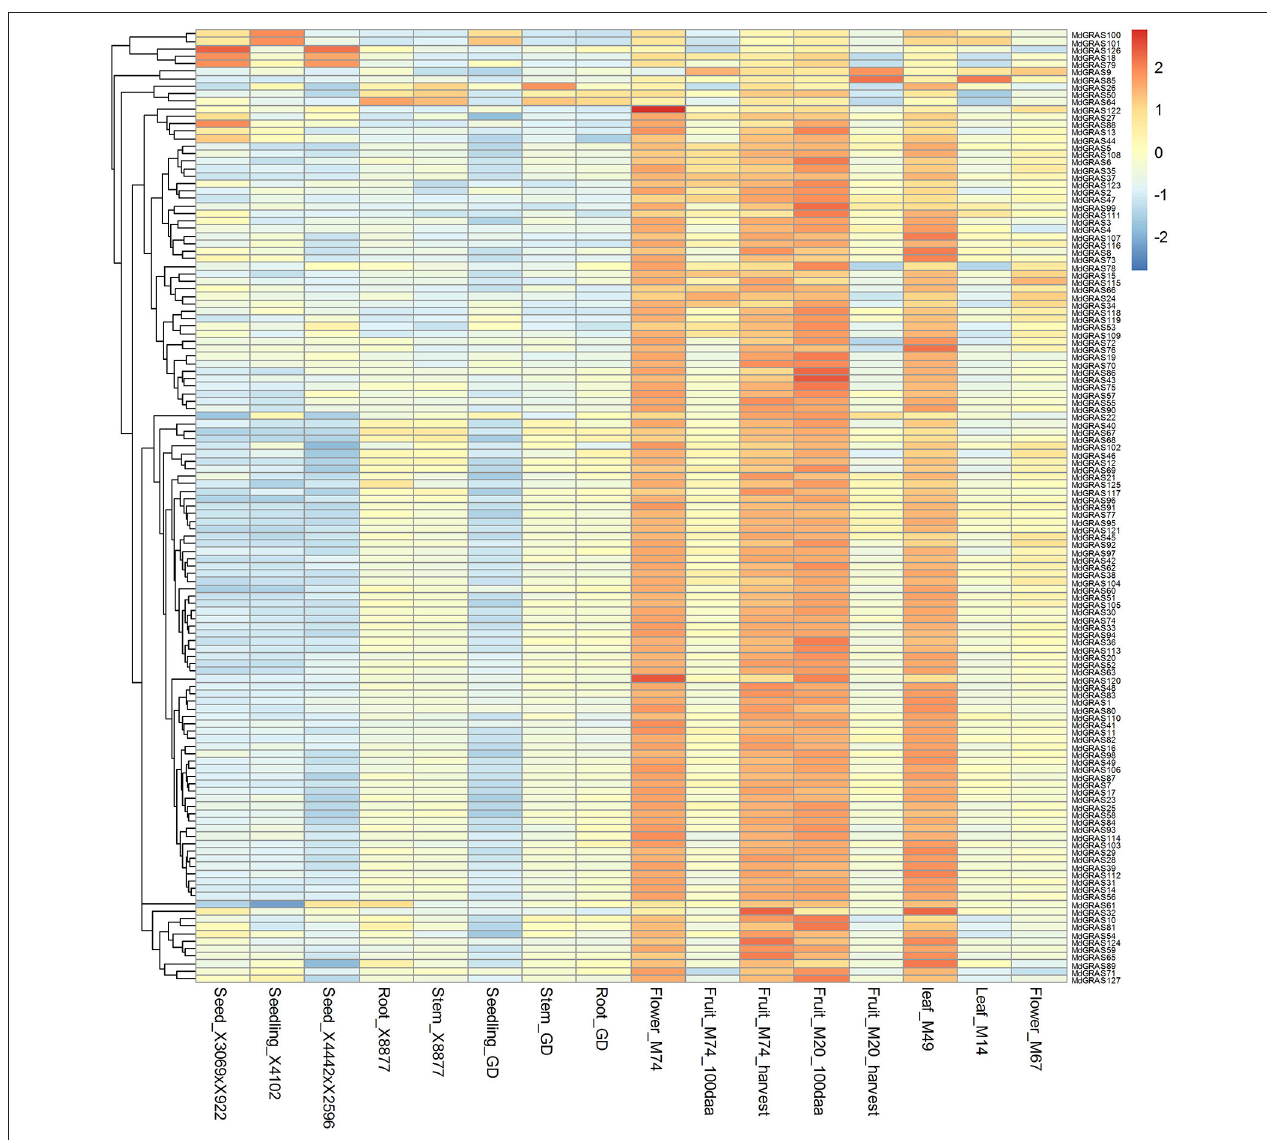
FIGURE 5 | Heat map showing MdGRAS gene transcript levels in different tissues. Relative transcript levels are based on ArrayExpress